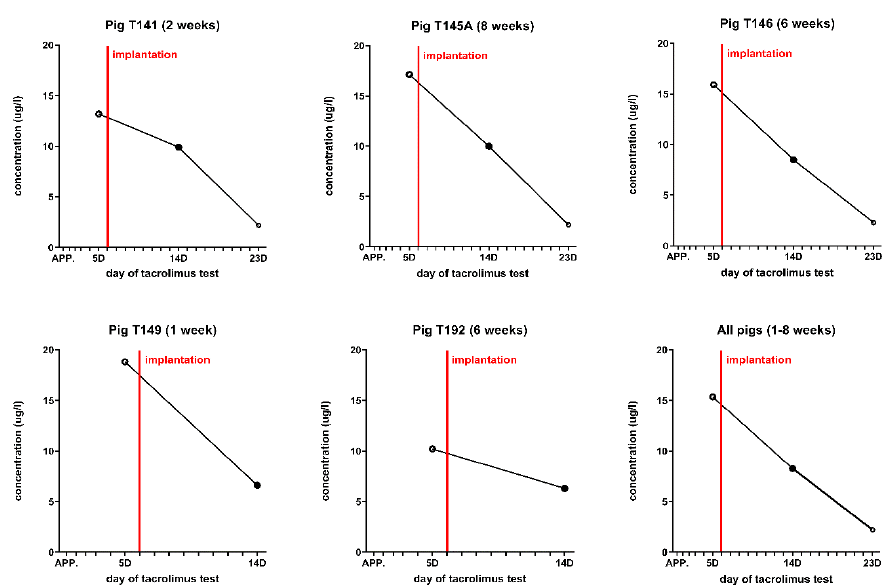
Figure 2. Tacrolimus blood levels measured throughout the experimental studies in minipigs. The concentration of tacrolimus in the blood was examined on Days 5, 14, and 23 after initial application. 2.8. Implantation of hRPEs on a Nanofibrous Carrier into Minipigs Five minipigs treated with tacrolimus-eluting polymer microspheres w ere used throughout the experiment and followed up to 8 weeks (Table 1).